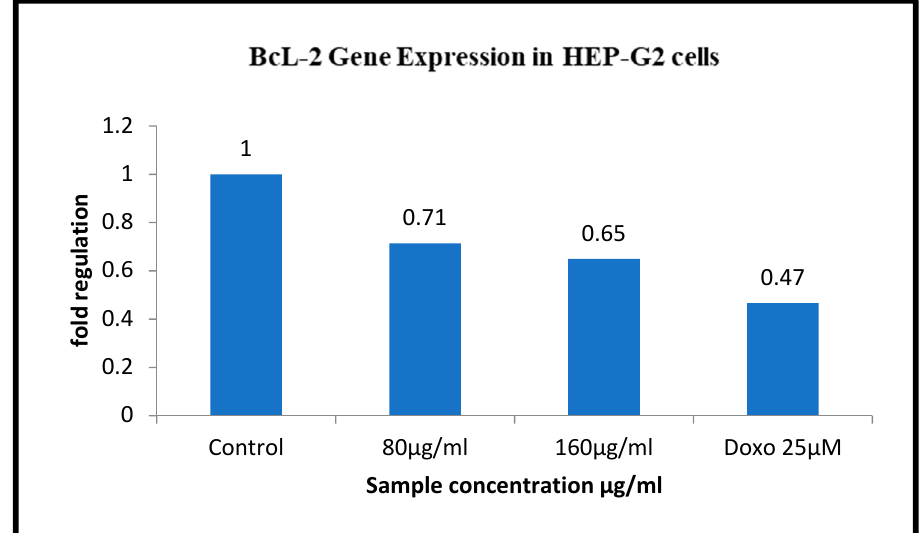
Figure 16. Graphical representation of BCl2 gene expression.